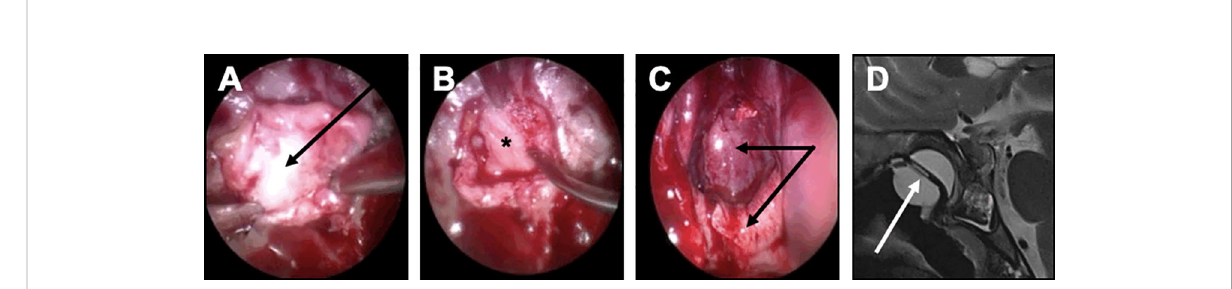
FIGURE 5 Closure strategy in patients with a risk factor. For these patients, a Foley urinary catheter is usually necessary and more complex multilayer closure strategies using a pedicled mucosal nasoseptal fl ap should be discussed. (A-D) Complex multilayer closure strategy for a patient with a recurrent pituitary adenoma treated with multiple surgery and radiotherapy. (A) After a muscle graft has been introduced in the intrasellar compartment, an autologous fascia lata graft has been positioned anterior to the sella turcica (black arrow). (B) After the fascia lata has been embedded in the epidural space with a bone graft (black asterisk), the primary sealing is obtained. (C) A vascularized mucosal nasoseptal fl ap is positioned and deployed in the sphenoid sinus (double black arrow), maintained using a Foley urinary catheter for 5 days. (D) Postoperative MRI showing the multilayer reconstruction and the Foley catheter (white